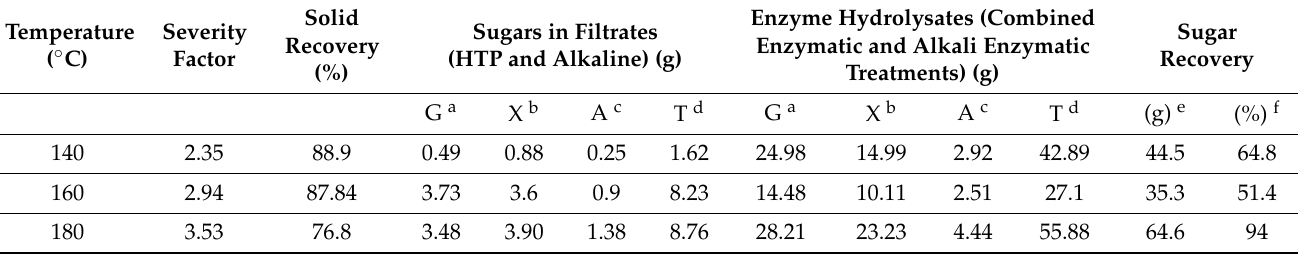
Table 4. Material balances from hydrothermal pretreatment followed by alkali, enzymatic and combined alkali enzymatic